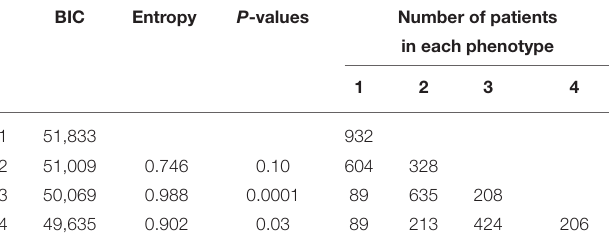
TABLE 2 | Fit statistics for latent class analysis